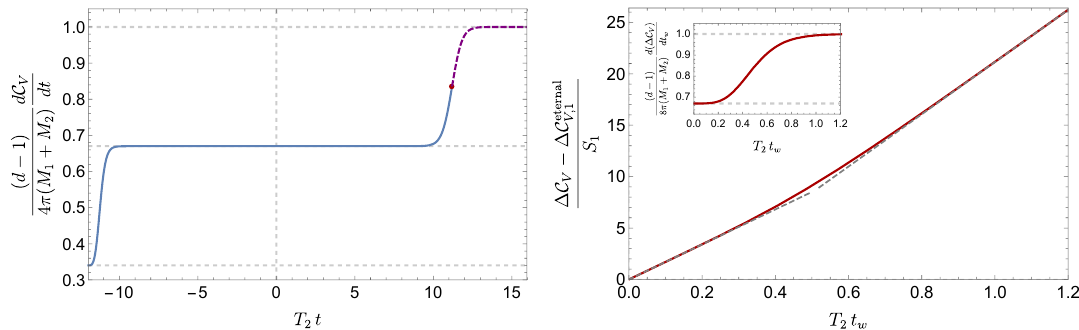
Figure 21. Numerical results for the complexity in shock wave backgrounds in planar ( k = 0) black holes in d = 4 with w r h; 2 =r h; 1 = 1 : 5. Left: rate of change of complexity as a function of (cid:17) time for symmetric evolution with t L = t R = t= 2 with an early shock sent at T 2 t w = 6. We have started the plot at t = 2 t w and indicated by horizontal dashed lines three di(cid:11)erent limits (in the (cid:0) relevant normalization as indicated on the axis) | the limit of times close to t L = t R = t w (see (cid:0) eq. (4.25)), the plateau near t = 0 (see eq. (4.23)), and the late time limit (see eq. (4.22)). The red dot indicates the point in which P 1 = 0 which signals the transition of the surface from the white hole to the black hole region in BH 1 . Right: complexity of formation as a function of the shock time t w shifted and normalized as in eq. (4.40). We have indicated by dashed lines the predicted slopes (see eqs. (4.38){(4.39)). The inset shows the derivative and its agreement with the predicted